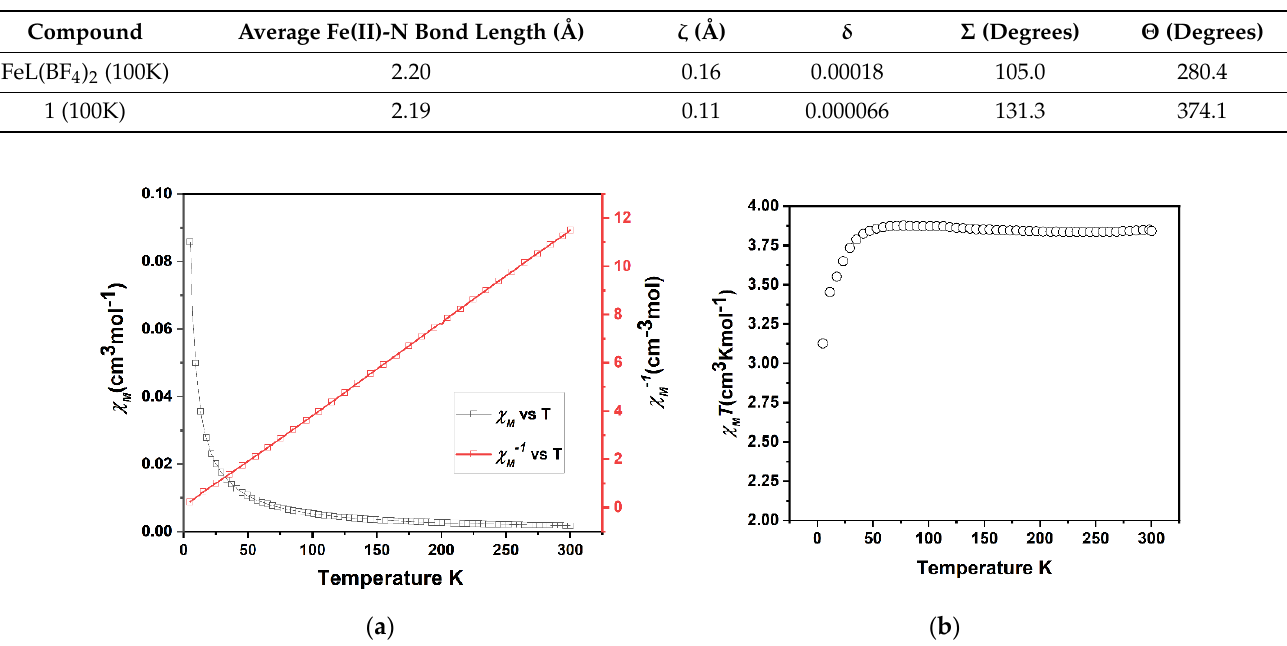
Figure 4. A crystal of cage 1 shown as an optical microscope image (Top left); a backscattering SEM image (Top middle left); corresponding EDS analysis results (Top middle right); atomic ratio of Fe and Pd (Top right); a backscattering SEM image of a single crystal of cage 1 (Bottom left); and X-ray mapping (Bottom). The EDS spectrum confirms an atomic ratio of Fe:Pd ≈ 4:3. The X-ray mapping